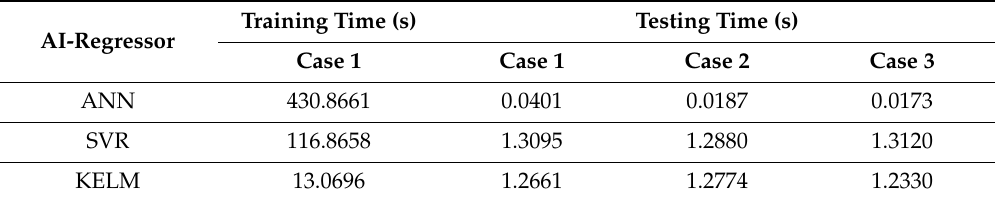
Table 3. Training and testing time for AI execution